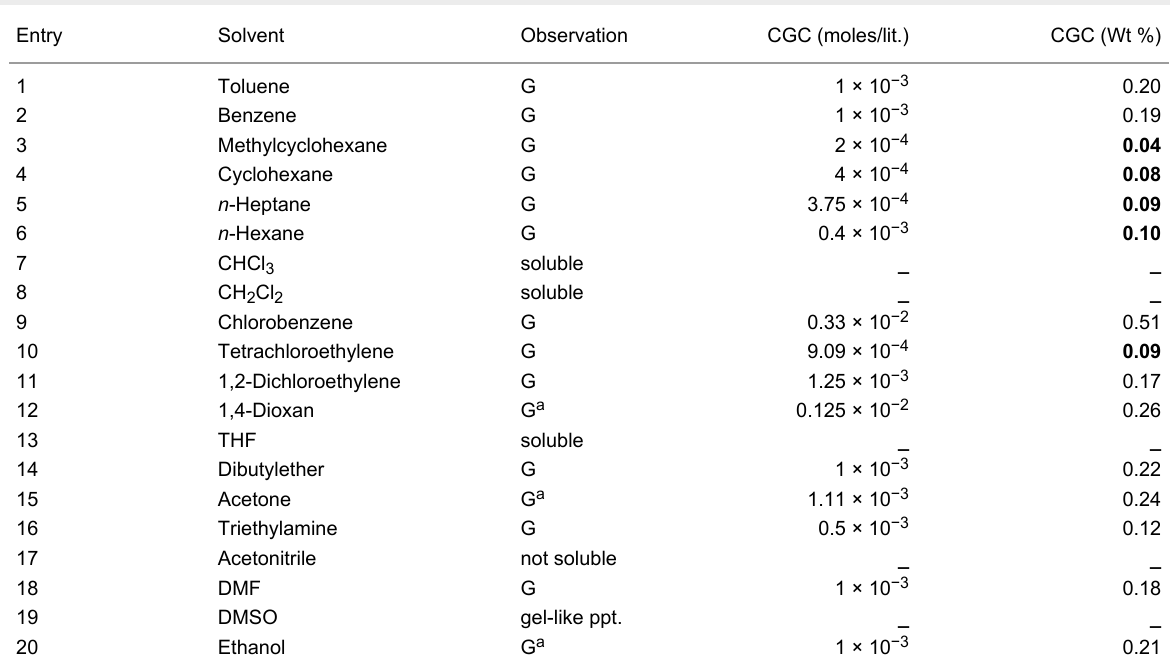
Table 1: Gelation studies of T1 in various